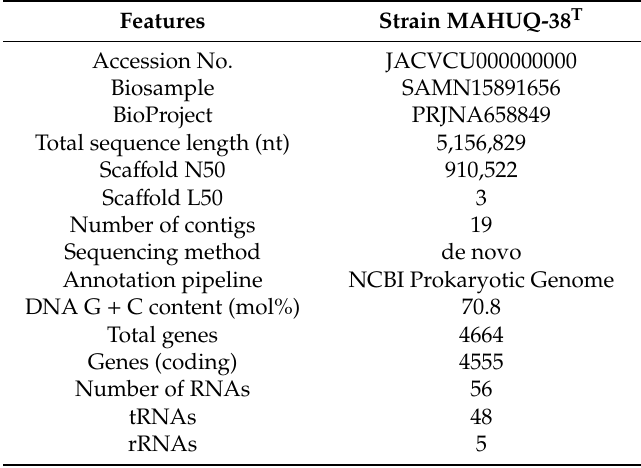
Table 2. Genome sequence features of Terrabacter humi MAHUQ-38 T